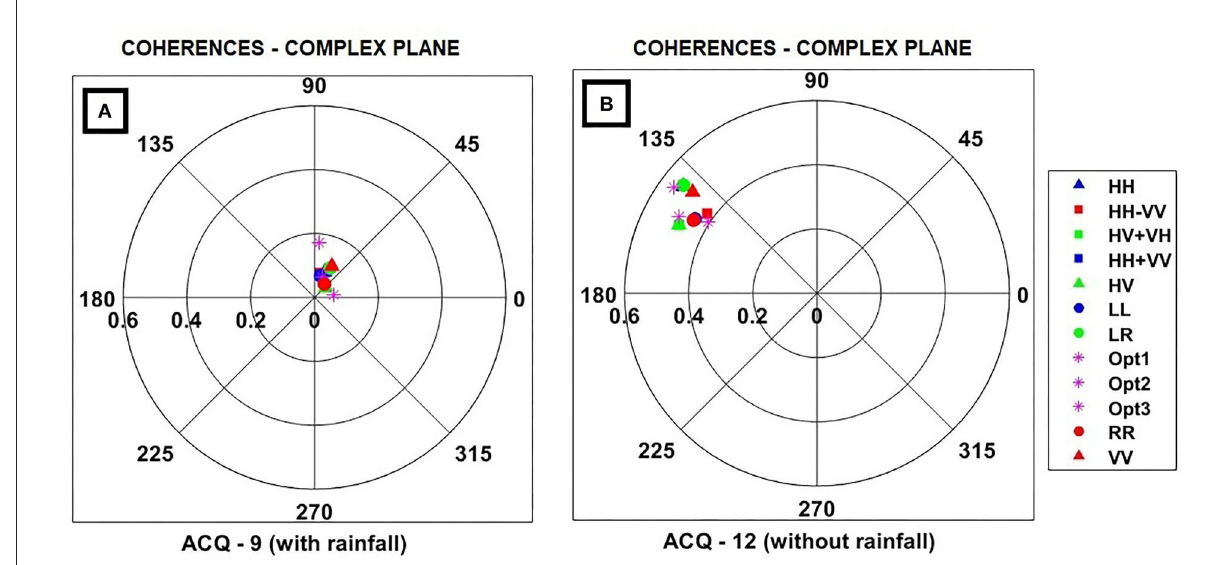
FIGURE8 Polarimetric variation of interferometric coherence. Complex coherences are plotted for linear, Pauli, circular, and optimal basis. Color code opted: Blue - HH, HH VV, LL; Green - HV, HV VH, LR; Red - VV, HH-VV, RR; Magenta - optimal basis. (A) Complex plane signature of ACQ-9 + + (with rainfall). (B) Complex plane signature of ACQ-12 (without